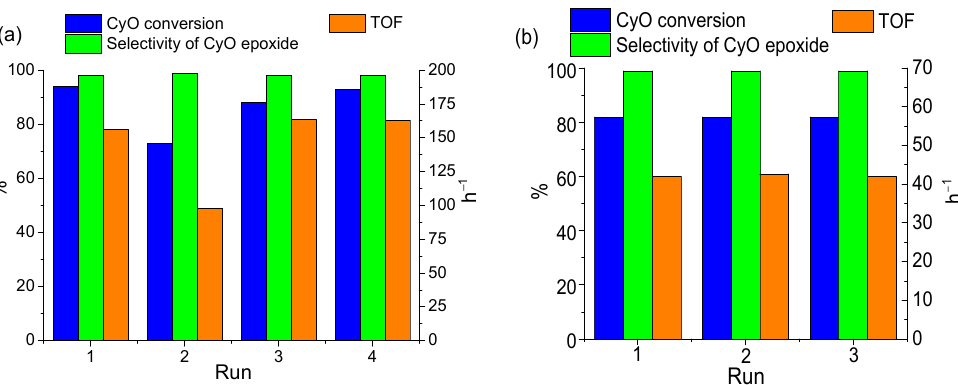
Figure 14 . Reusability of the catalysts ( a ) 8 wt. % NbW 5 /CNTs and ( b ) 5 wt. % PW 4 /CNTs in CyO epoxidation. Reaction conditions: [CyO] = 0.1 M, [H 2 O 2 ] = 0.2 M, 20–30 mg catalyst (0.7 μ mol PW 4 , 0.8 μ mol NbW 5 ), DMC 1 mL, 50 °C. The catalyst 8 wt. % NbW 5 /CNTs was treated with HClO 4 in CH 3 CN (2 equiv. to POM) after the second and subsequent runs. a) Adapted from ref. [103] with permission from the Royal Society of Chemistry.